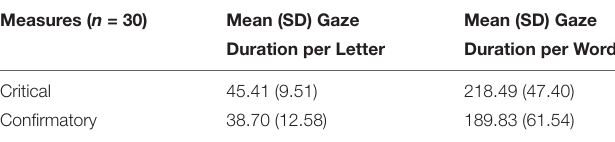
TABLE 1 | Means and standard deviations of critical and confirmatory feedback assigned per game.